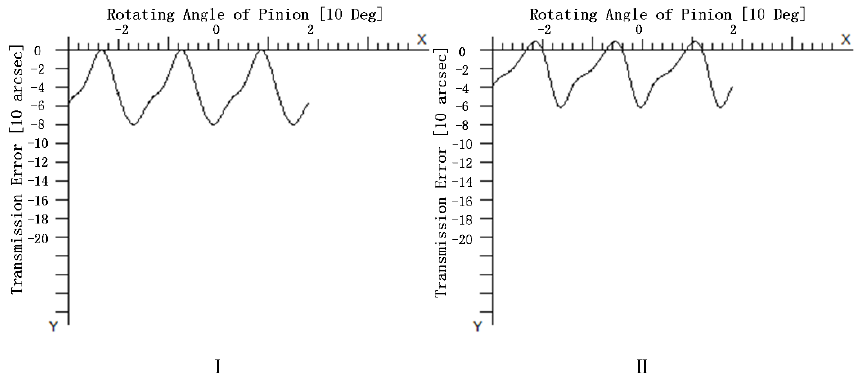
Figure 14. LTE curves at a load of 100 N·m: ( I ) Unmodified; ( II ) Modification.